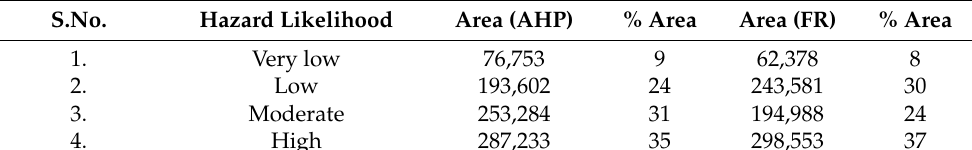
Figure 4. Groundwater arsenic hazard map for the Ganga basin using ( a ) AHP, ( b ) FR. Table 5. Arsenic prediction by selected geostatistical methods. S.No.